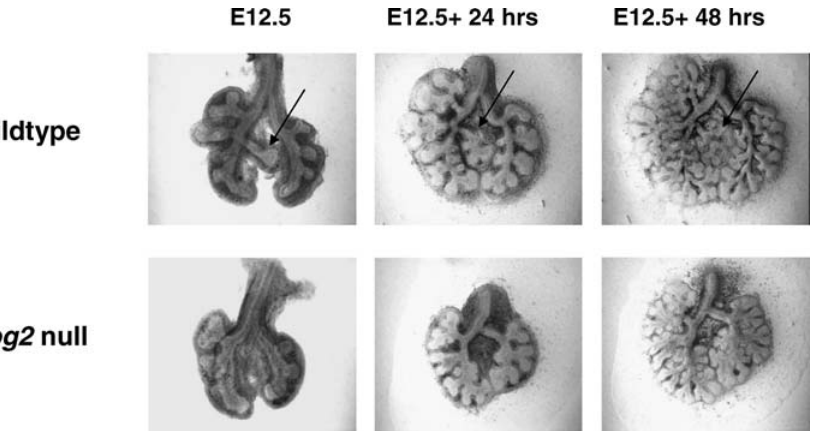
Figure 4. Fog2 Is Necessary for Primary Lung Development Fog2 null lungs removed prior to diaphragmatic muscularization and grown in vitro show no accessory lobe development. Accessory lobe is labeled with black arrow in control littermate lungs. DOI: